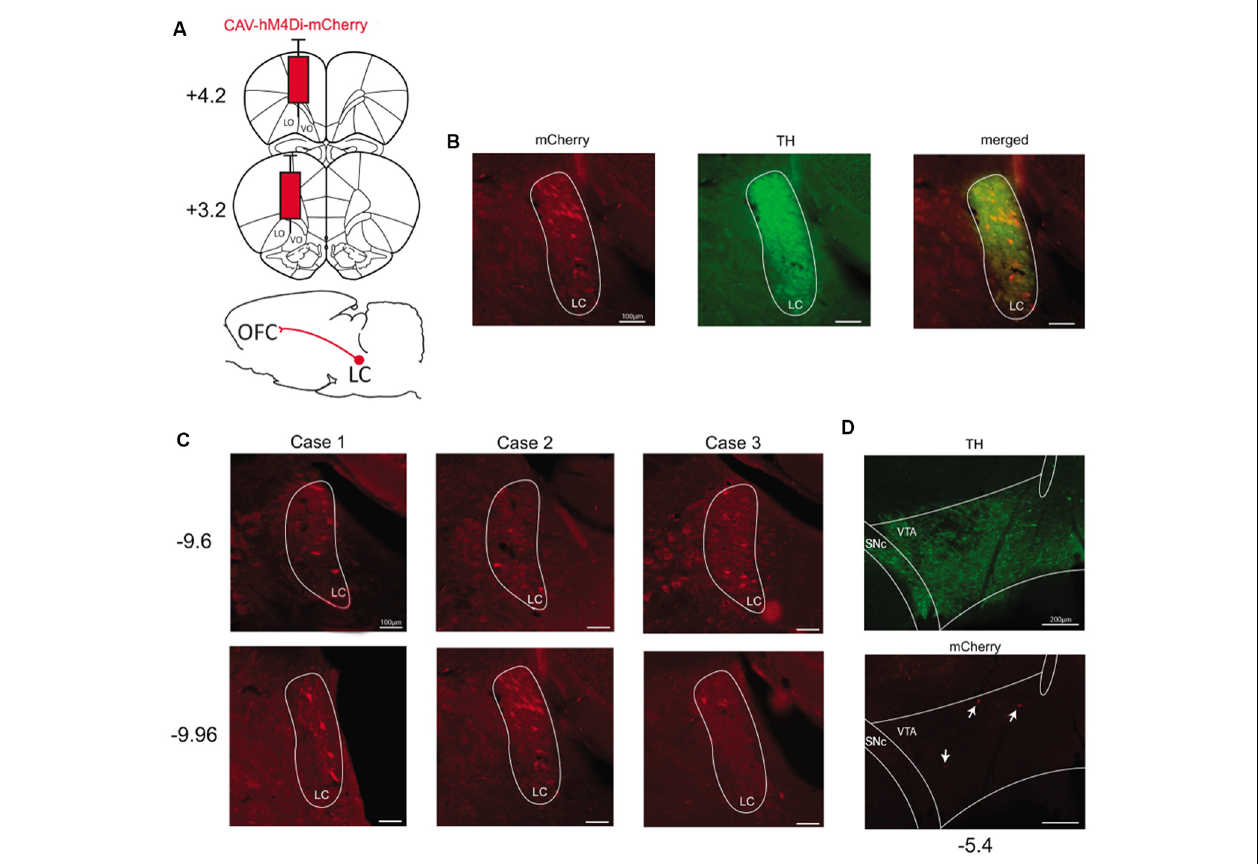
FIGURE 2 | Targeting the catecholaminergic pathway to the OFC. (A) Schematic illustration of viral vector injection into the OFC at two different coordinates taken from Bregma (AP +3.2 mm and AP +4.2 mm). (B) Example of staining obtained in the LC for mCherry-positive and TH-positive neurons (Case 2, AP − 9.96 mm). (C) Staining obtained in LC for all pilot cases at two different anteroposterior coordinates taken from Bregma (AP − 9.6 mm and AP − 9.96 mm). (D) Example of staining obtained in the VTA for mCherry-positive and TH-positive neurons (AP − 5.4 mm). OFC, orbitofrontal cortex; VO, ventral OFC; LO, lateral OFC; LC, locus coeruleus; VTA, ventral tegmental